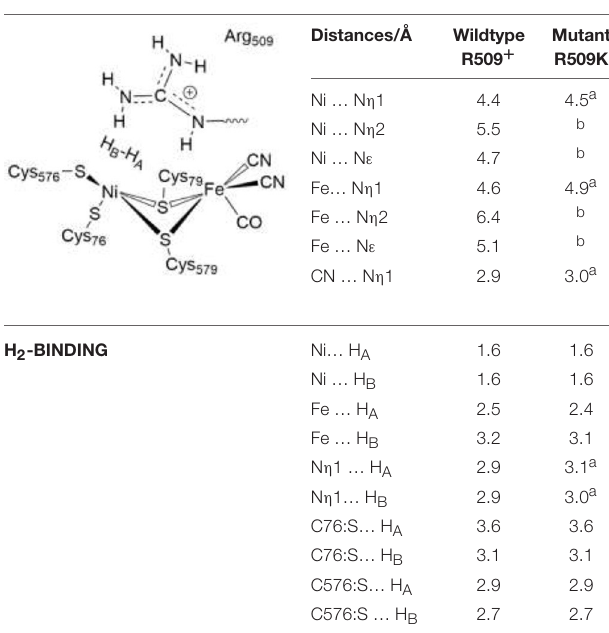
TABLE 4 | Structural data of the H 2 Ni-SIa complexes of the wildtype E. coli Hyd-1 and the R509K variant optimized using the larger QM2 region.